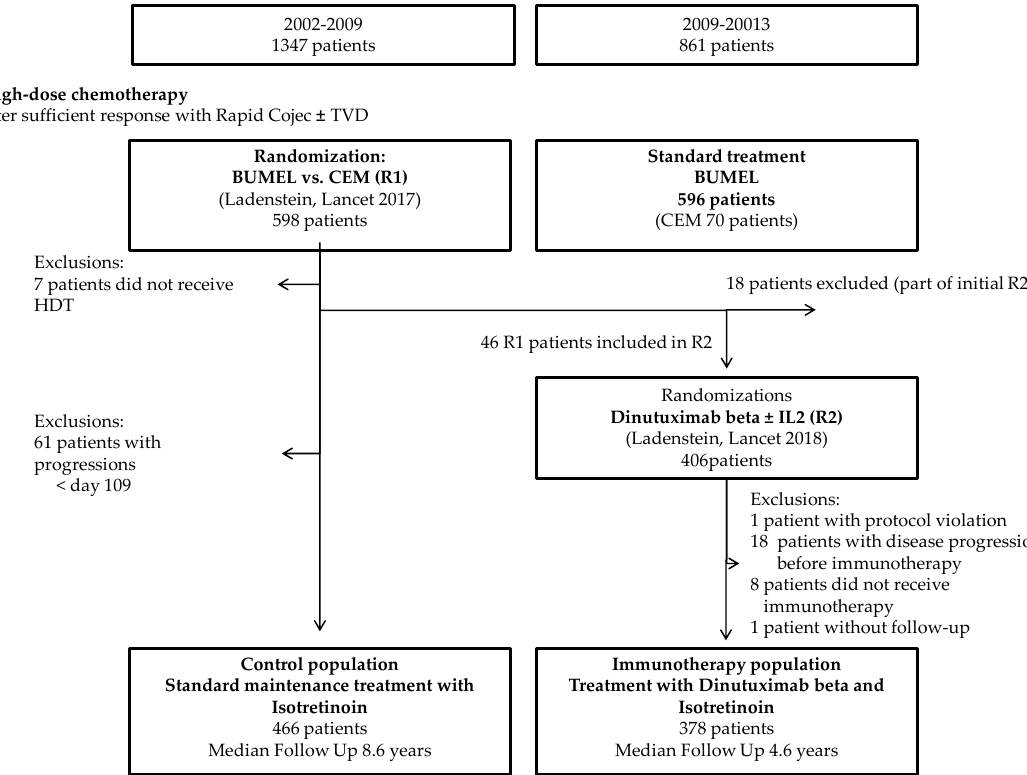
Table 1. Characteristics of the control and immunotherapy populations. N = number; % = percentage;